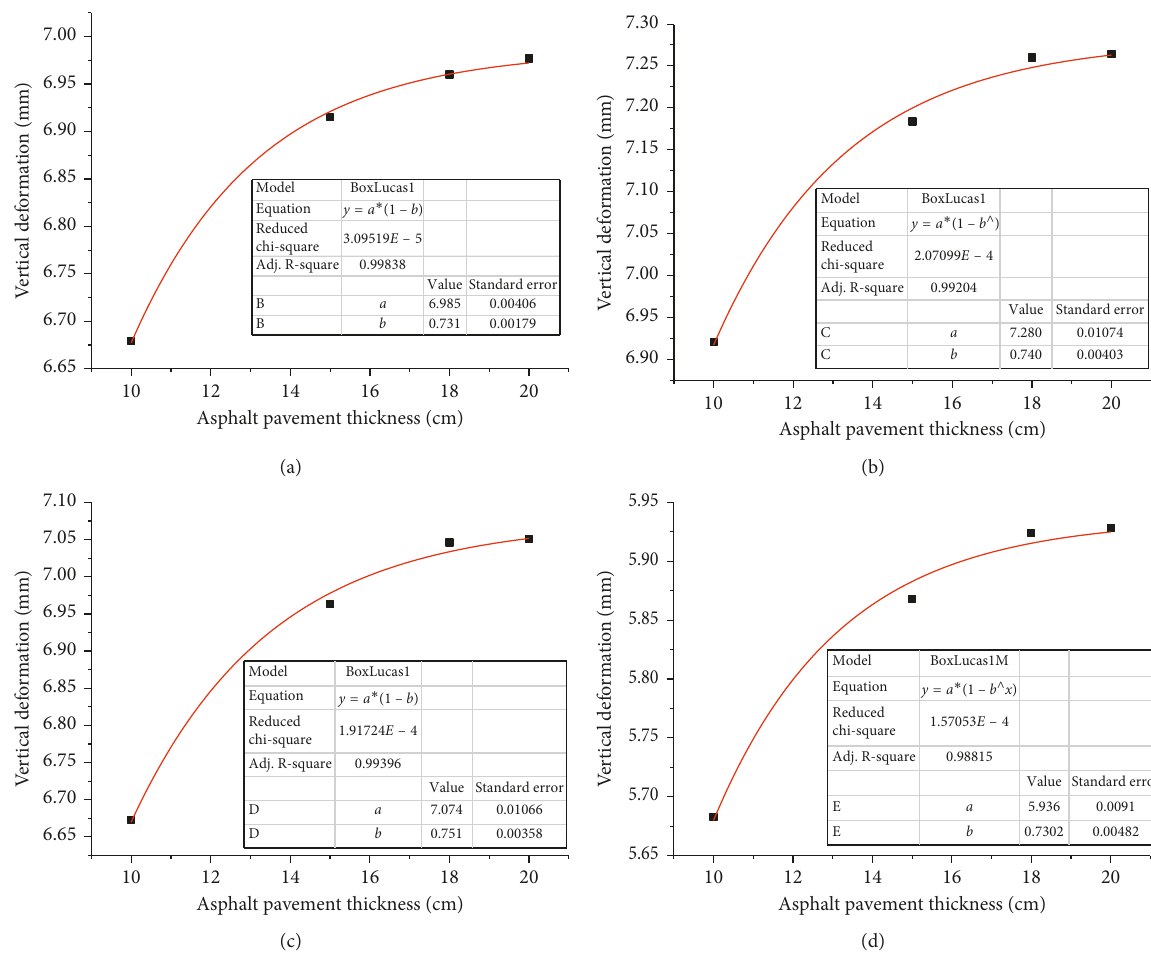
Figure 7: Vertical deformation of the road for 20cm thickness of the gravel base.